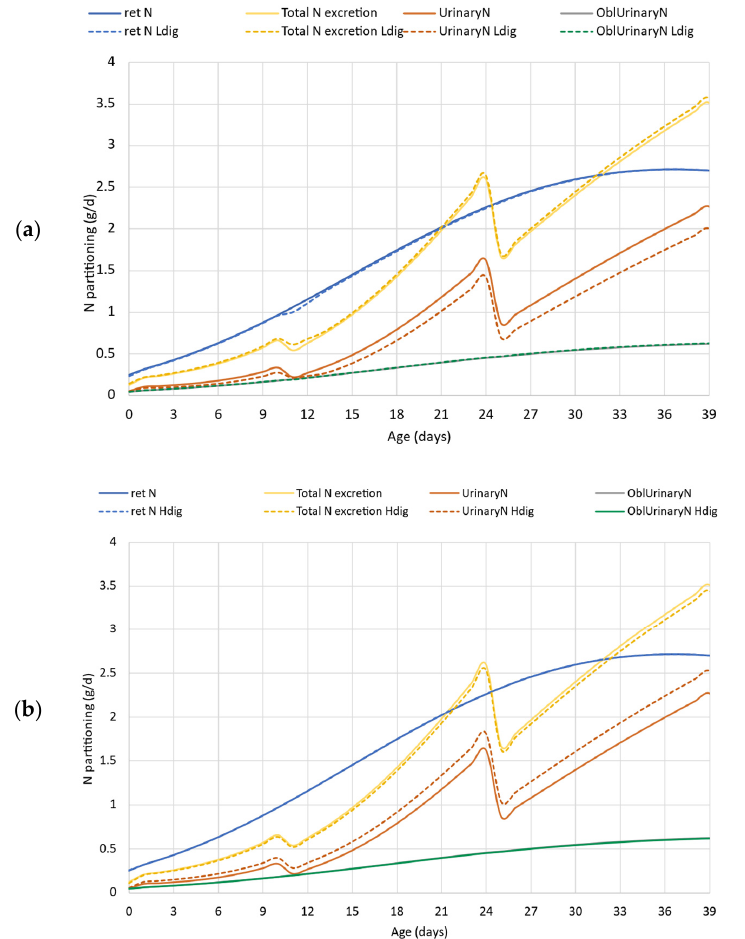
Figure 6. Case study 2. Effect of lower (80% vs. 75%, upper panel ( a )) and higher (80% vs. 85%, down panel ( b )) dietary crude protein digestibility on N excretion and its partitioning. ret N— retained nitrogen (g/d); Total N excretion—sum of fecal and urinary N excretions (g/d); Ldig—lower digestibility (75%); Hdig—higher digestibility (85%); UrinaryN—urinary nitrogen excretion, (g/d); OblUrinaryN—obligatory urinary nitrogen loss (g/d).